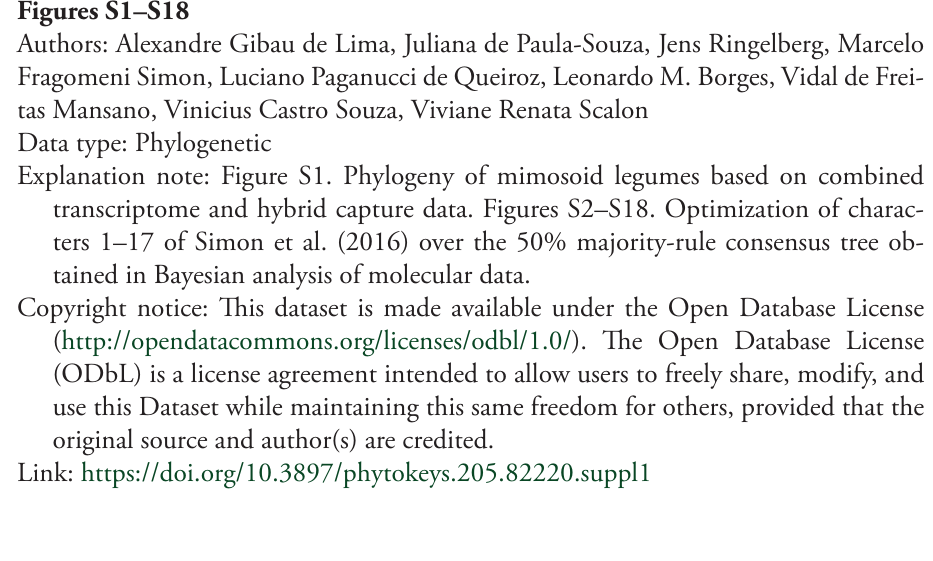
Explanation note: Figure S1. Phylogeny of mimosoid legumes based on combined transcriptome and hybrid capture data. Figures S2–S18. Optimization of charac- ters 1–17 of Simon et al. (2016) over the 50% majority-rule consensus tree ob- tained in Bayesian analysis of molecular